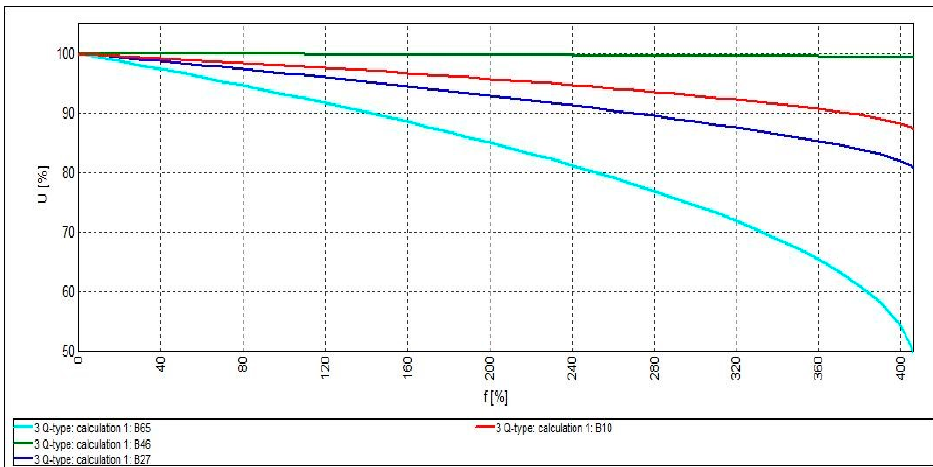
11 Figure 8. PV curves of the IEEE 69 ‐ node RDS system with 2 P ‐ type DG installations. Figure 8 shows that there is almost no drastic effect on the system’s PV curves when installing 2 P ‐ type DGs. The voltage of node 65—the system’s weakest node in that case—